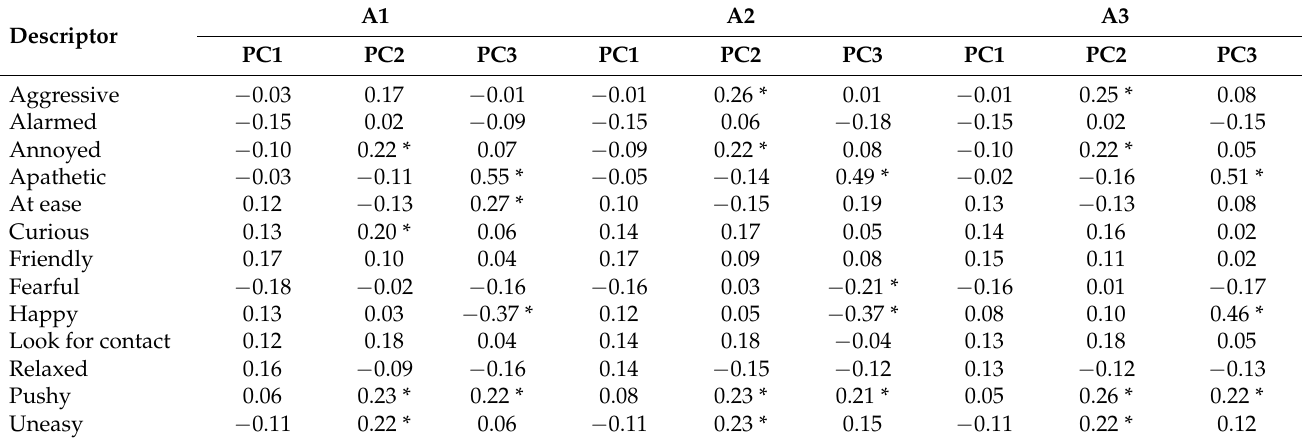
Table 6. Component score coefficient matrix for three principal components in the three qualitative behavior assessments of the